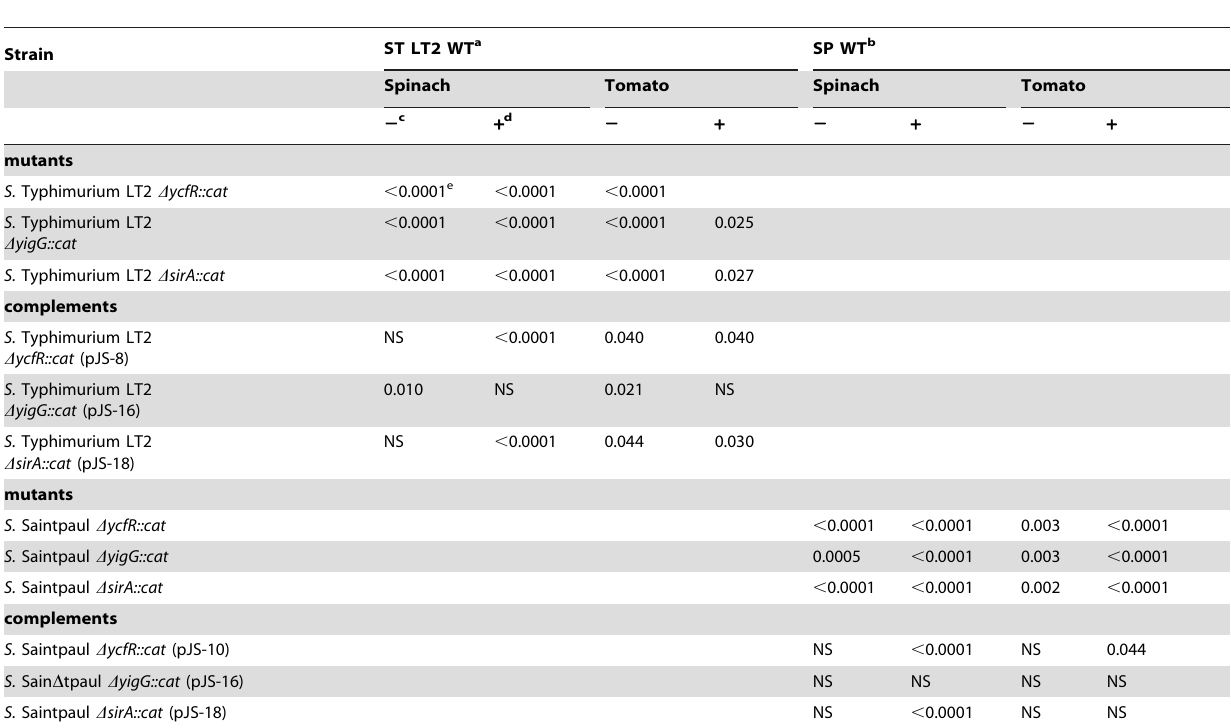
Table 3. Statistical analysis of S. enterica spinach and tomato attachment assays with and without chlorine treatment.